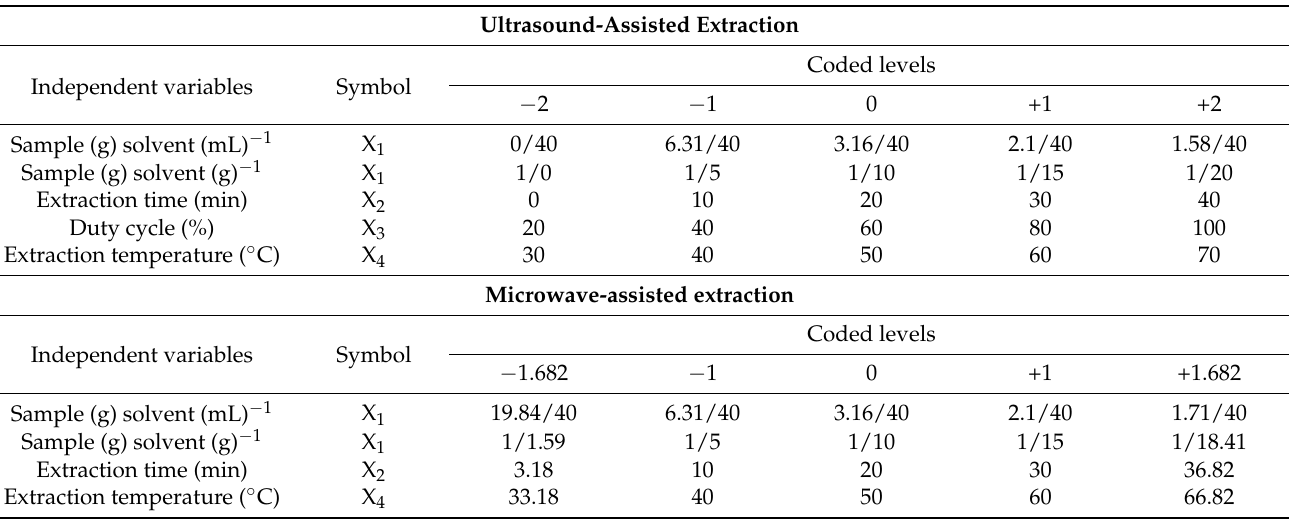
Table 10. Uncoded and coded levels of the independent variables for ultrasound- and microwave- assisted extraction of